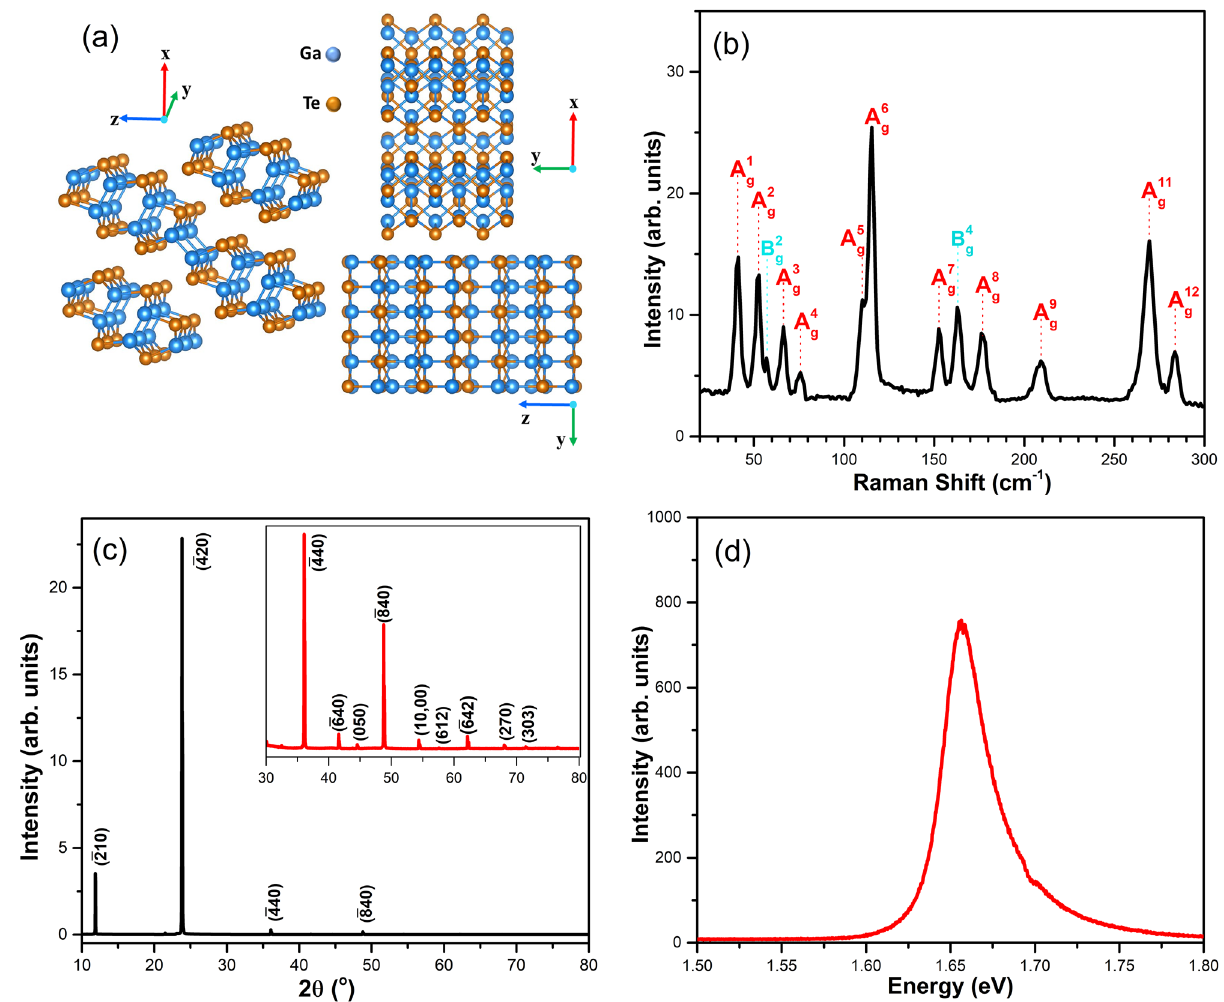
Figure 1. ( a ) Crystal structure of GaTe, shown in perspective view, side view, and top view of three stacked layers. The drawing was created by using VESTA version 3 (https:// jp- miner als. org/ vesta/ en/ downl oad. html). ( b ) Typical Raman spectrum of bulk-GaTe measured by using a 532 nm laser line at room temperature. ( c ) XRD patterns of GaTe. ( d ) PL spectrum of bulk-GaTe at room